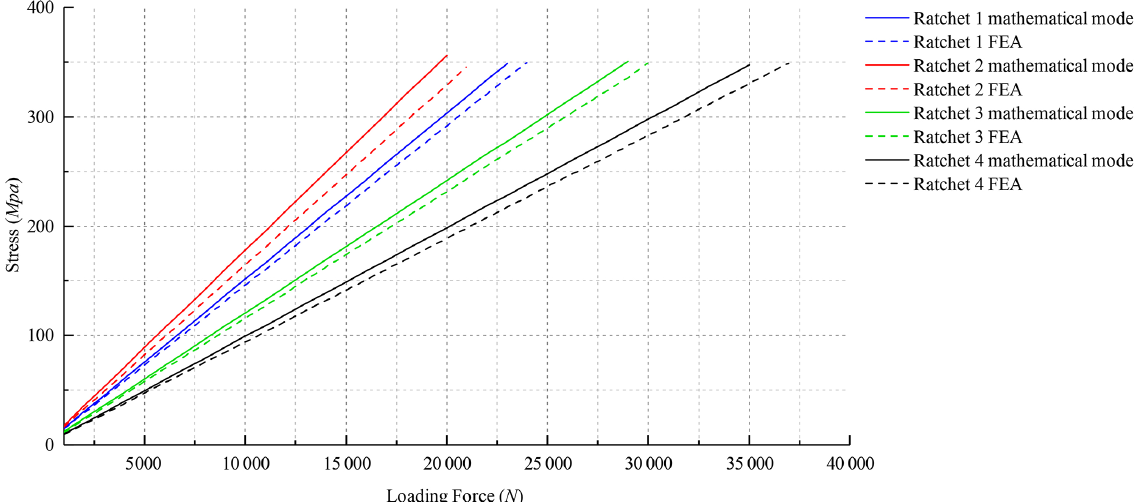
Figure 8. The FEA simulation data and model analysis data of ratchets 1, 2, 3 and 4.